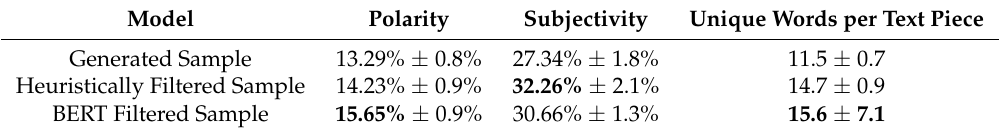
Table 1. Comparison of initial GPT-generated texts, heuristically filtered texts and texts after BERT filtration with 95% confidence intervals. Polarity and subjectivity are calculated by TextBlob library. Absolute polarity is averaged over the text samples of comparable length. Resulting texts become more and more emotional in terms of absolute sentiment. The resulting Paranoid Transformer texts have the highest average number of unique words per sentence and the highest variation in terms of the length of the resulting texts. The highest number in every column is highlighted with